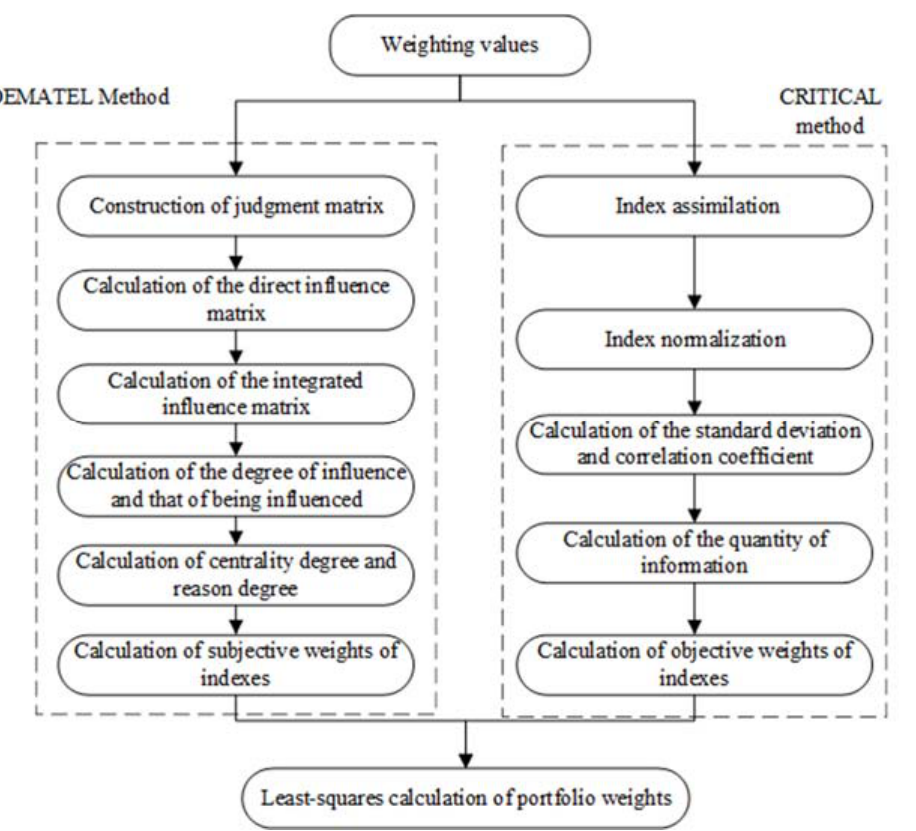
Figure 5. Flow chart of weighting by DEMATEL–CRITIC and least-squares method. The index weight is obtained from subjective and objective aspects. The DEMATEL method was used for subjective weights and the CRITIC method was used for objective weights, and then the subjective and the objective weights of the indexes were combined by the least-squares method. Finally, the profit ratio values of each scenario were calculated and ranked based on the VIKOR